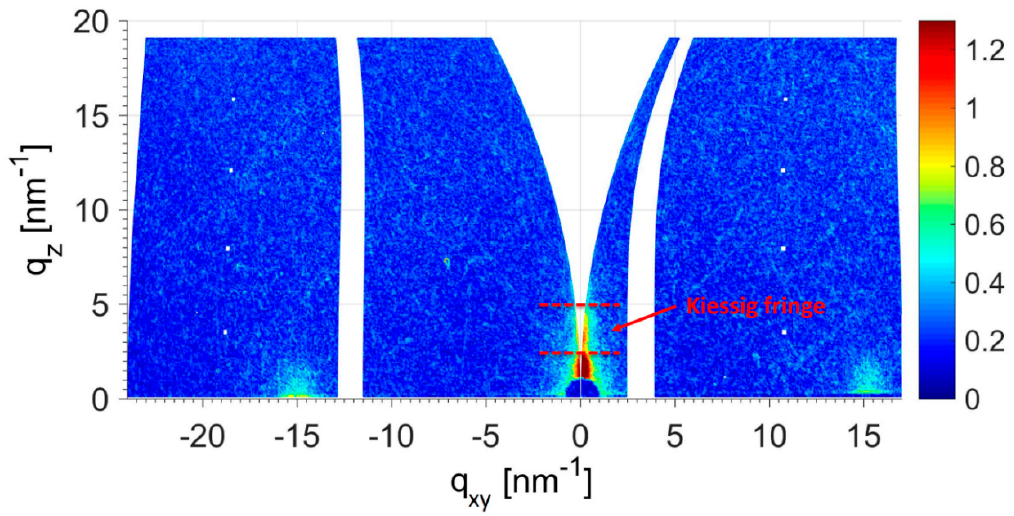
Figure 7. 2D GI-WAXS pattern of the LB film of Ethoxy-PPE transferred at 15 mN / m (after the plateau zone) of the π - A isotherm. The two vertical bands in the image are the empty space between the detectors and appear as blank. The dotted red lines are drawn in to the q z axis to guide the range of the Kiessig fringe.